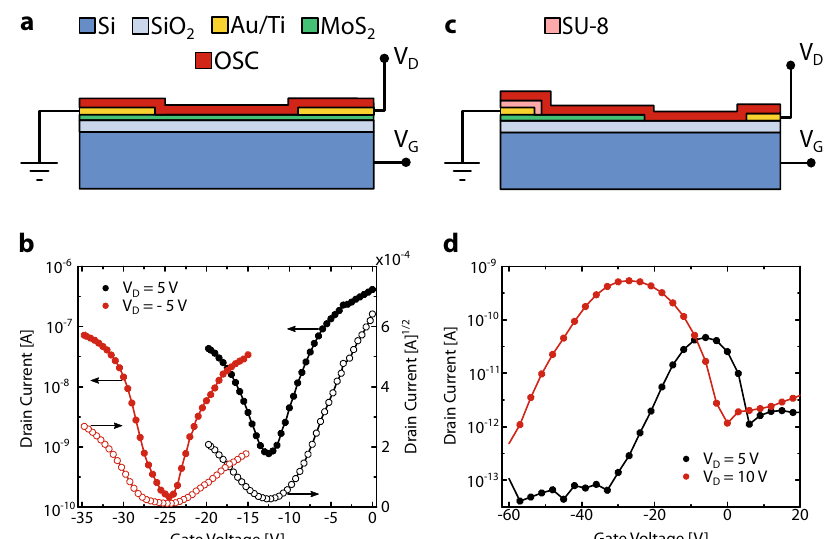
Fig. 4 Electrical characterization of ambipolar and antiambipolar devices fabricated by assembly of OSC nanosheets with ML MoS 2 . a Schematic of the ambipolar FET device. As illustrated, the Au/Ti contacts are placed between the ML MoS 2 and the 50 nm thick DNTT nanosheet. Here the channel width and length are 10 µm. b Drain current as a function of gate voltage of the ambipolar FET device for two different drain voltages (5.0 V and − 5.0 V). Filled and hollow circles refer to logarithmic and square root axis, respectively. c Schematic diagram of antiambipolar FET device. The source and drain electrode are individually contacted to the ML MoS 2 and pentacene nanosheet, respectively. The pentacene/ML MoS 2 heterojunction is 15 µm along the channel. d Drain current of the antiambipolar device as function of gate voltage for two different drain voltages (5.0 V and 10.0